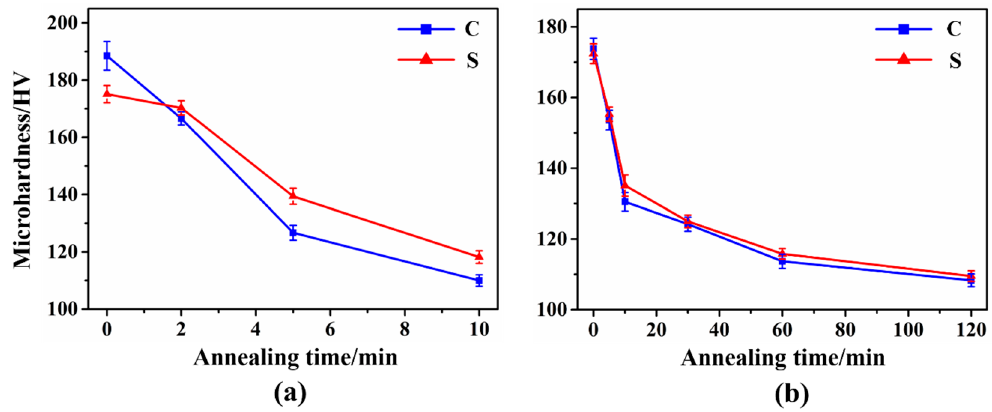
Figure 10. Evolution of micro-hardness of UR and CR-Ta samples as a function of annealing time in the surface and center regions: ( a ) UR-Ta; ( b ) CR-Ta.